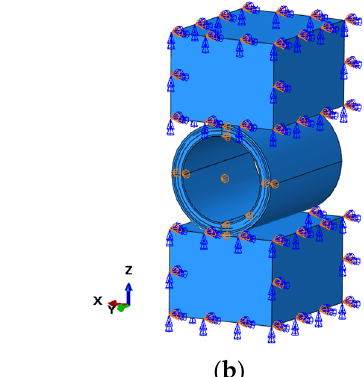
( b ) Figure 10. FE result of the hose under crush load: ( a ) displacement; ( b ) stress. Figure 11. Calculated load ‐ displacement relationship with the FE model.